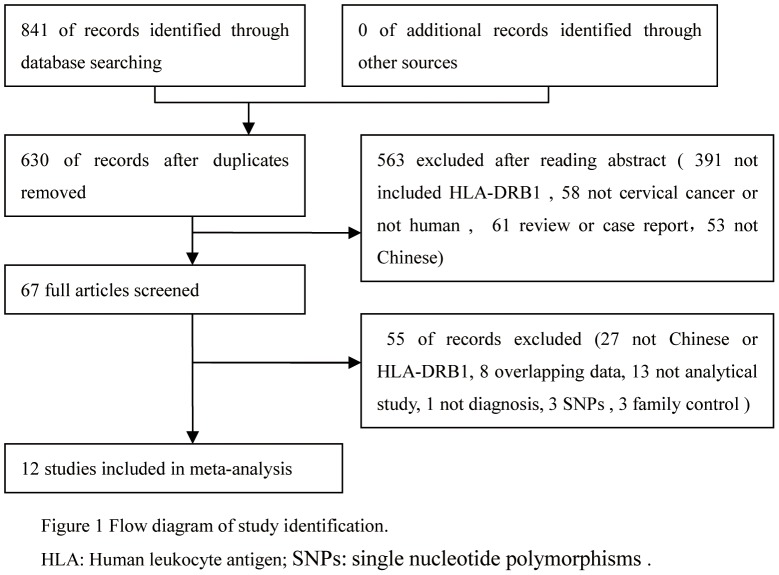
Flow diagram of study identification.